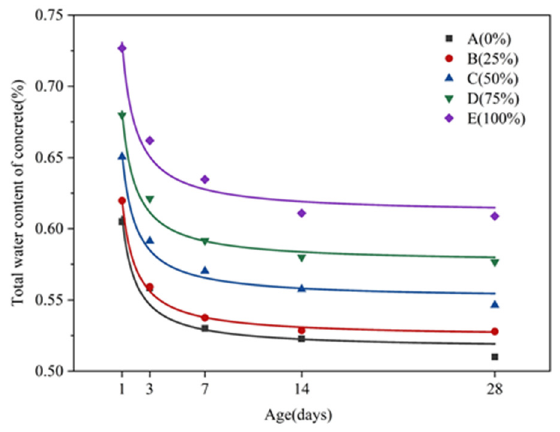
Figure 10. Fitting curve of total water content of concrete.